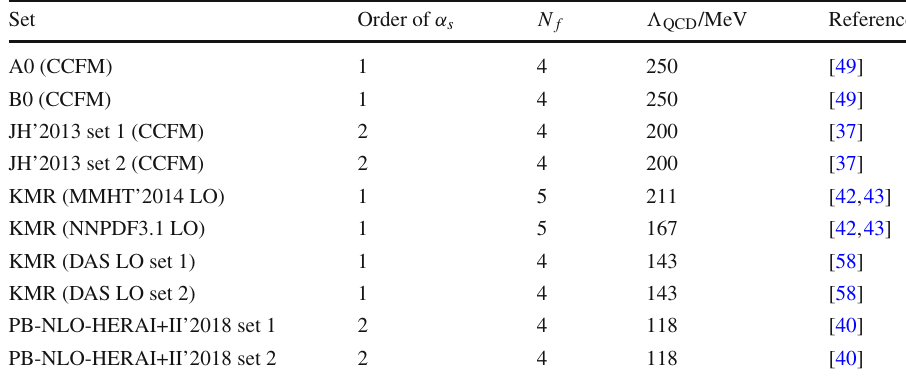
Table 1 The TMD gluon densities in a proton implemented into the pegasus . The A0 ± , B0 ± , JH’2013 set 1 ± and JH’2013 set 2 ± distributions, needed to estimate the scale uncertainties of the calculations (see below), are not shown